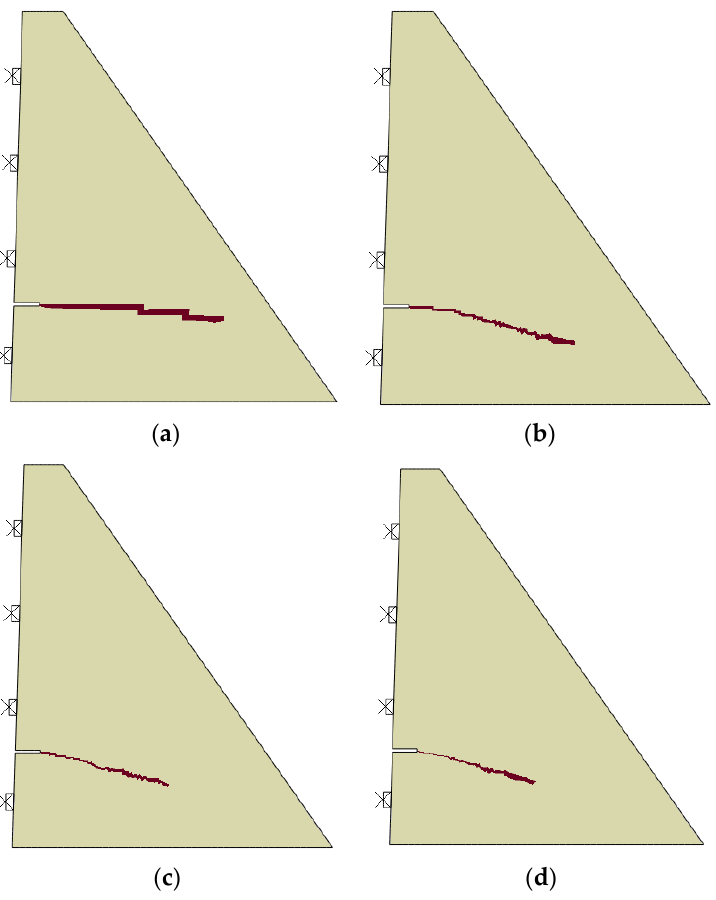
Figure 7. Crack trajectories for different refinement levels using fib model code 2010 [32] bilinear softening model: ( a ) mesh 1, ( b ) mesh 2, ( c ) mesh 3, ( d ) mesh 4.